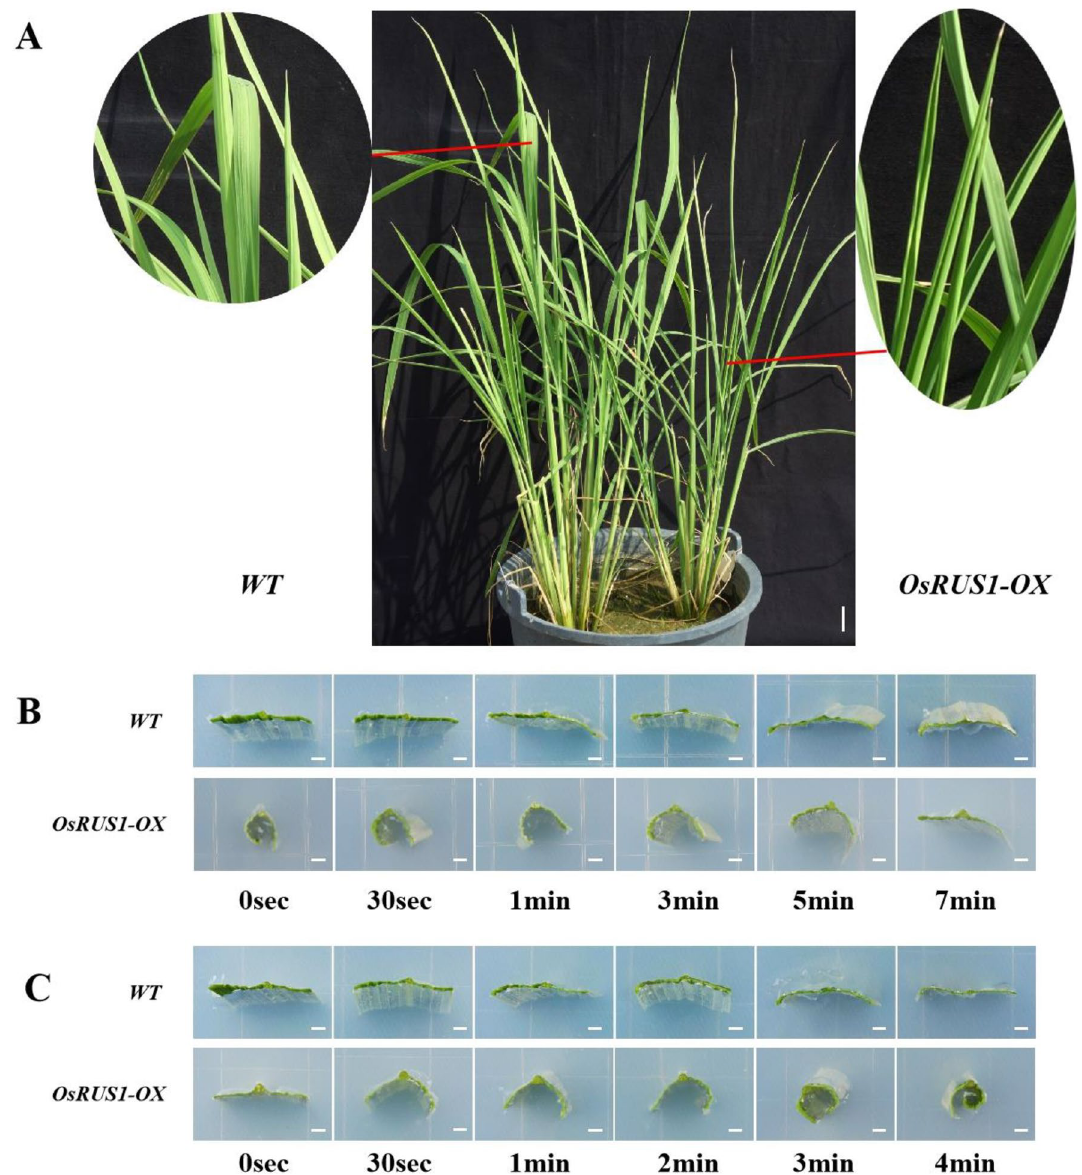
Figure 1. Leaf rolling morphology of WT and OsRUS1-OX in response to sunlight. ( A ) Morphology of the WT and OsRUS1-OX under sunlight, scale bar 2 cm; ( B ) The rapid leaf expanding in OsRUS1-OX when the sunlight was shaded, scale bar 2 mm; ( C ) The rapid leaf rolling in OsRUS1-OX in response to sunlight, scale bar 2 mm. WT, the wildtype of ZhongHua11; OsRUS1-OX , the OsRUS1-GFP Overexpression transgenic